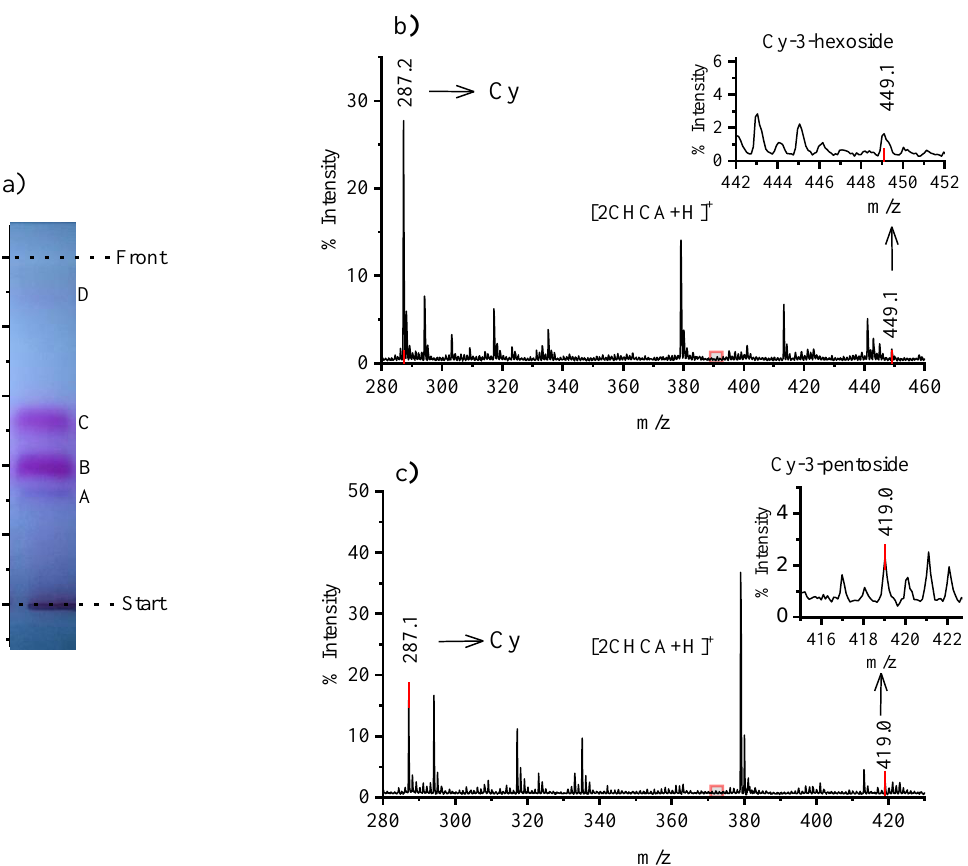
Figure 4. ( a ) Anthocyanins separated by TLC from mortiño extract (mobile phase: BAW 40:10:15, stationary phase: silica gel F 270 ). MALDI spectra (CHCA matrix) of ( b ) cyanidin-3-hexoside and ( c ) cyanidin-3-pentoside fraction.